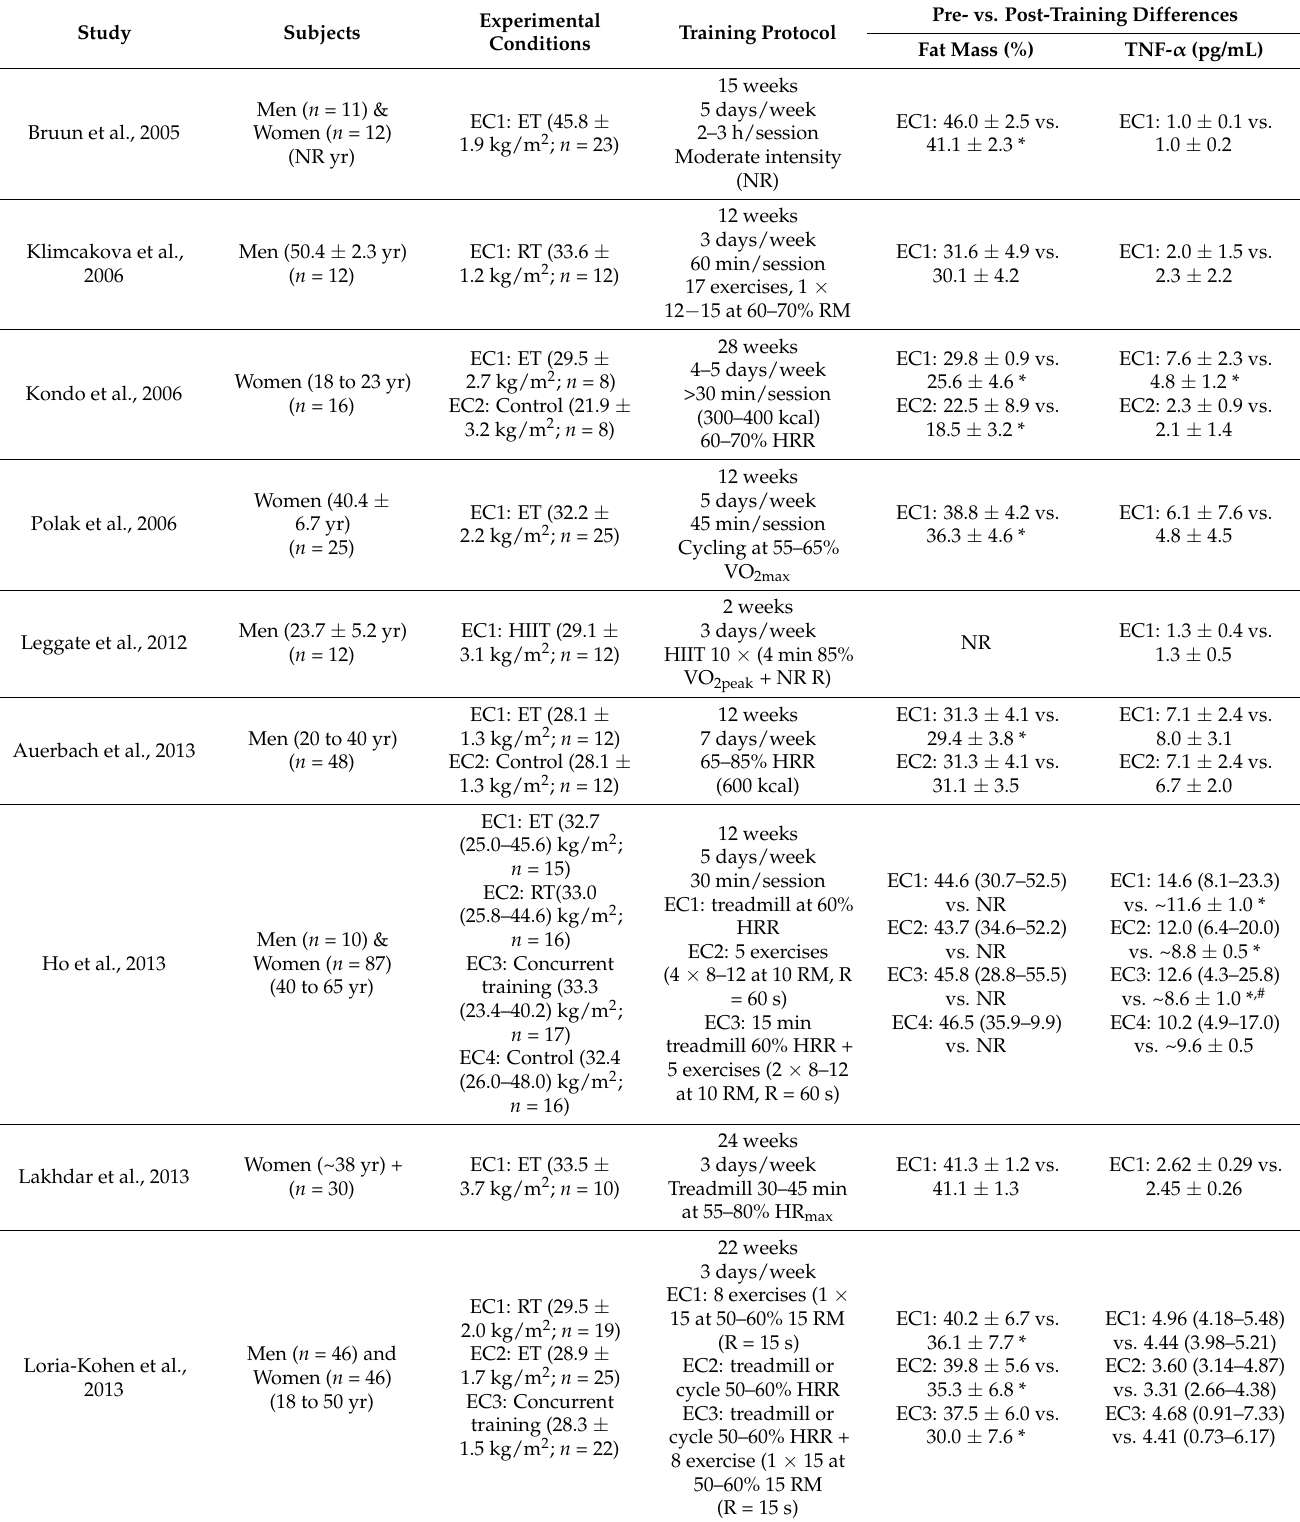
Table 4. Effects of training on the circulating concentrations of TNF- α in sedentary adults who were overweight or obese. Study Subjects